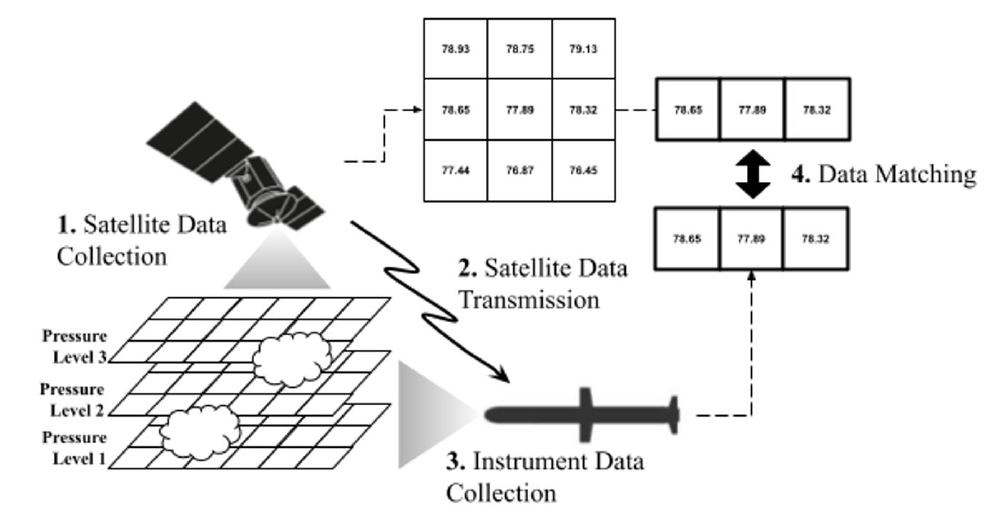
Figure 1. Meteorological Contour Matching (METCOM) data